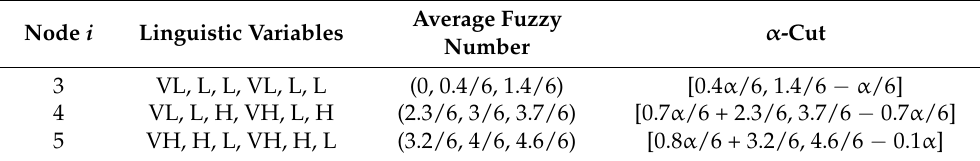
Table 6. Example of STEPs P0, P1, and P2.